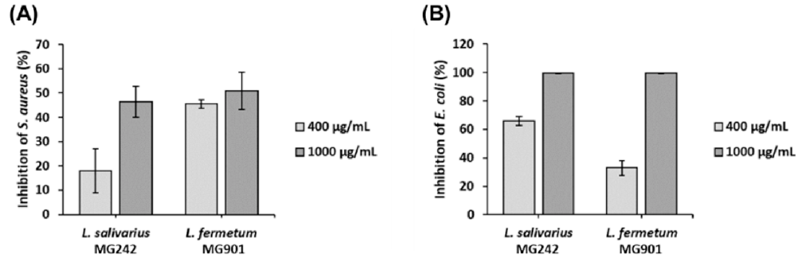
Figure 3. Effect of CFS derived from L. salivarius MG242 and L. fermentum MG901 on the growth of ( A ) S. aureus and ( B ) E. coli in the media. Data are shown as mean ± SD ( n = 3).